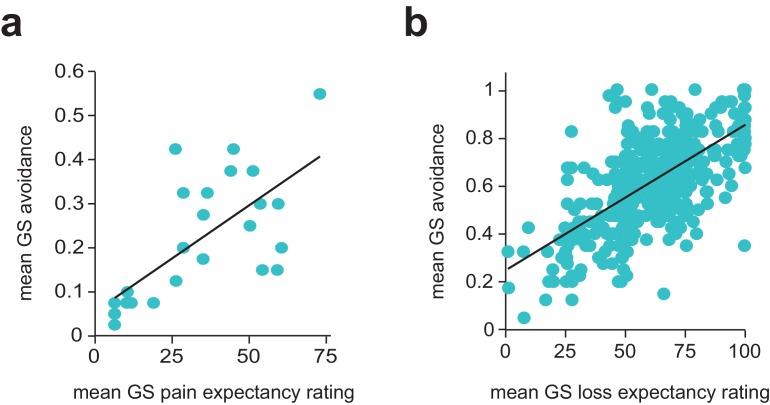
Relationship between mean avoidance on generalization stimulus (GS) trials during the generalization of instrumental avoidance task, and mean post-task visual analogue scale pain/loss expectancy ratings.(a) fMRI, (b) AMT, samples (Spearman’s ρ = 0.692, 0.641, respectively).